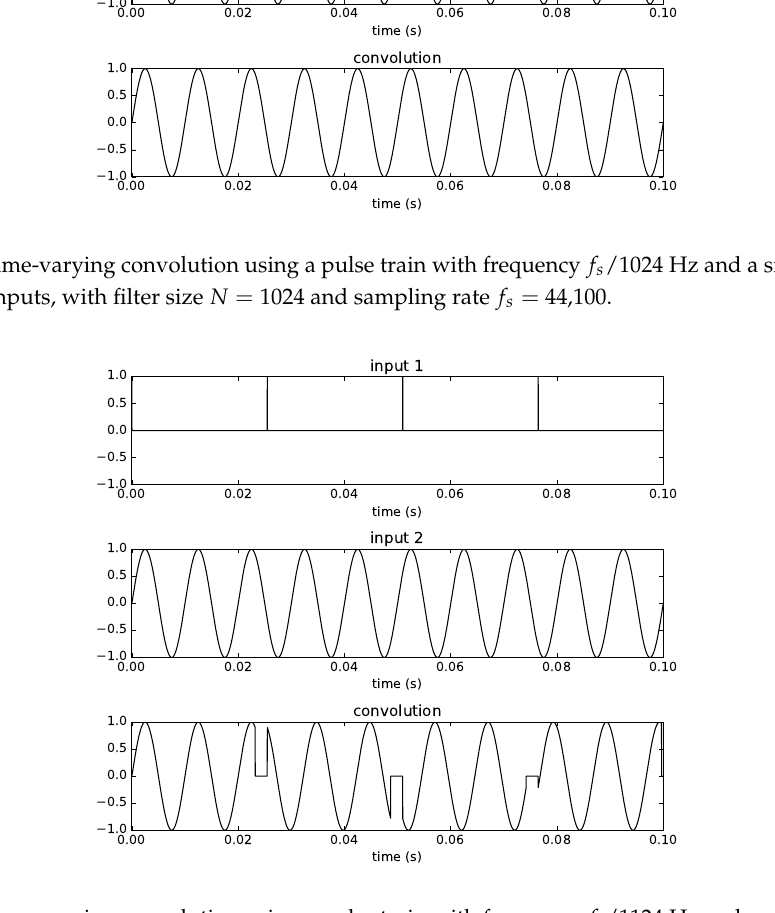
Figure 6. Time-varying convolution using a pulse train with frequency f s /1124 Hz and a sine wave of 100 Hz as inputs, with filter size N = 1024 and sampling rate f s =